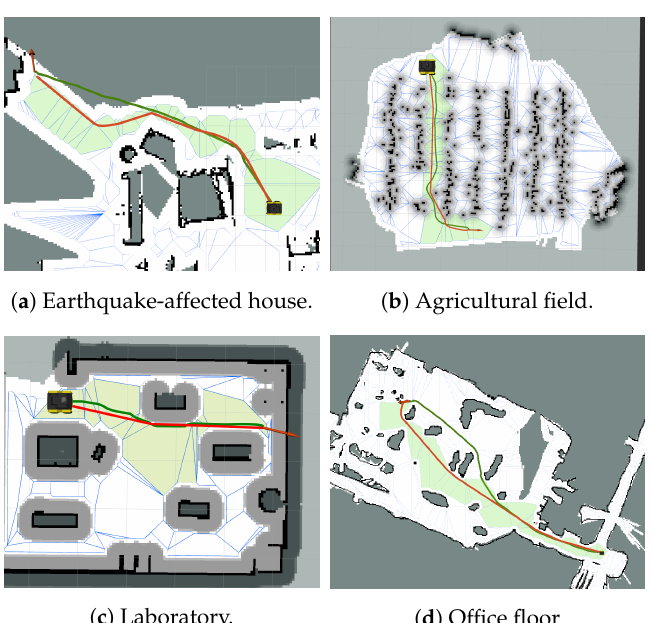
Figure A1. Path planning results for different occupancy grid maps; compares the performance of the Navigation with Polytopes toolbox (red lines) versus the standard Navfn in ROS (green